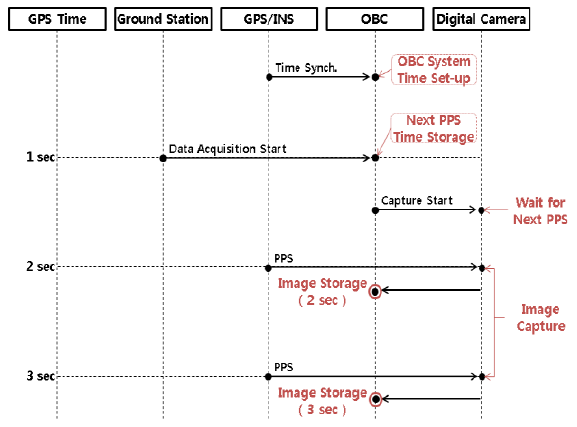
Figure 5. Time Synchronization of